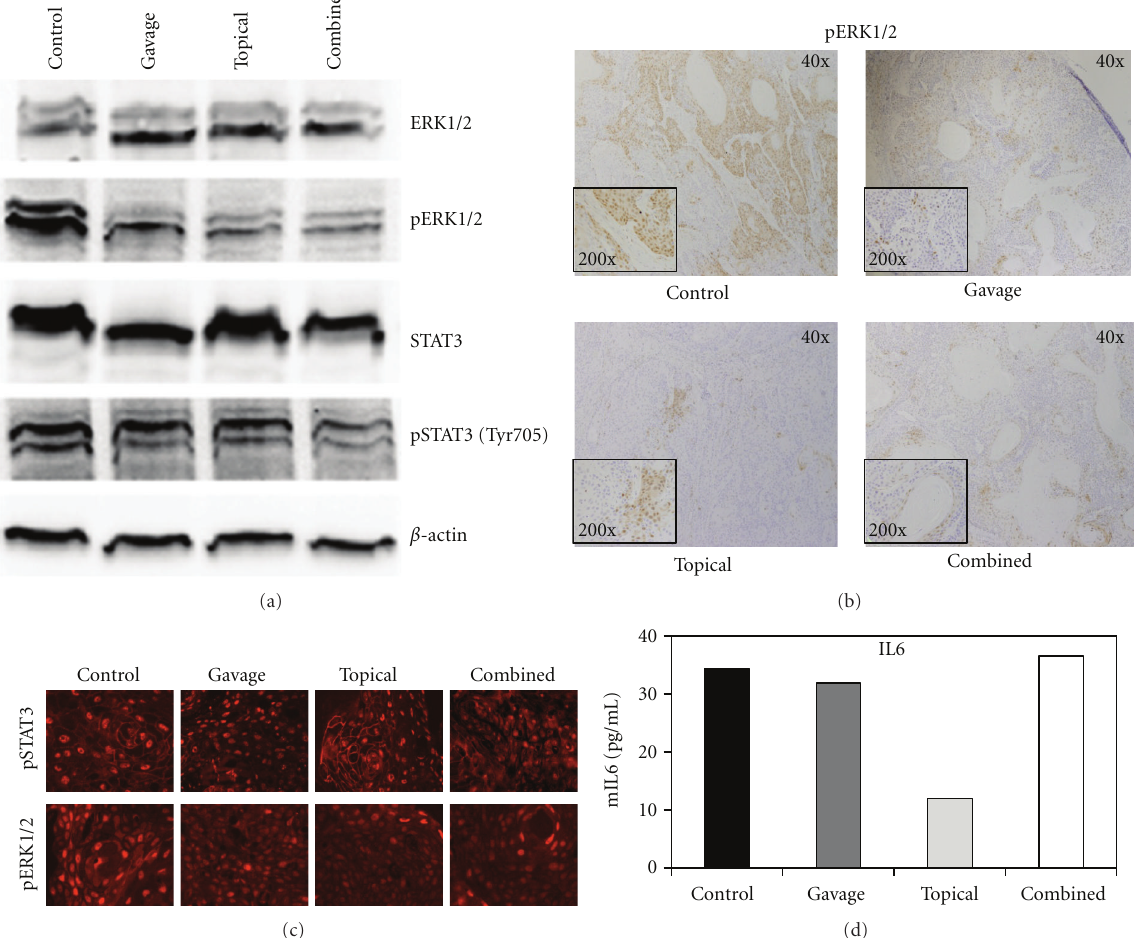
Figure 3: Curcumin’s e ff ects on the ERK pathway in vivo . (a) Western blot of pooled xenograft tumors ( n = 6 / group) of the indicated antibody. (b) The presence and intensity of pERK staining (brown) in the control group compared to the presence and intensity of pERK staining in the curcumin-treated xenograft tumors. (c) Representative IHC staining of SRB-12 p9 WT cell tumor xenografts. Para ffi n sections of tumors were probed with STAT3 phospho-Tyr705 (pSTAT3, top row) or ERK1/2 phospho-Thr202/Tyr204 (pERK, bottom row), followed by an Alexa546-labeled secondary antibody (400x). (d) IL-6 ELISA of pooled mouse serum ( n = 3 / group) in